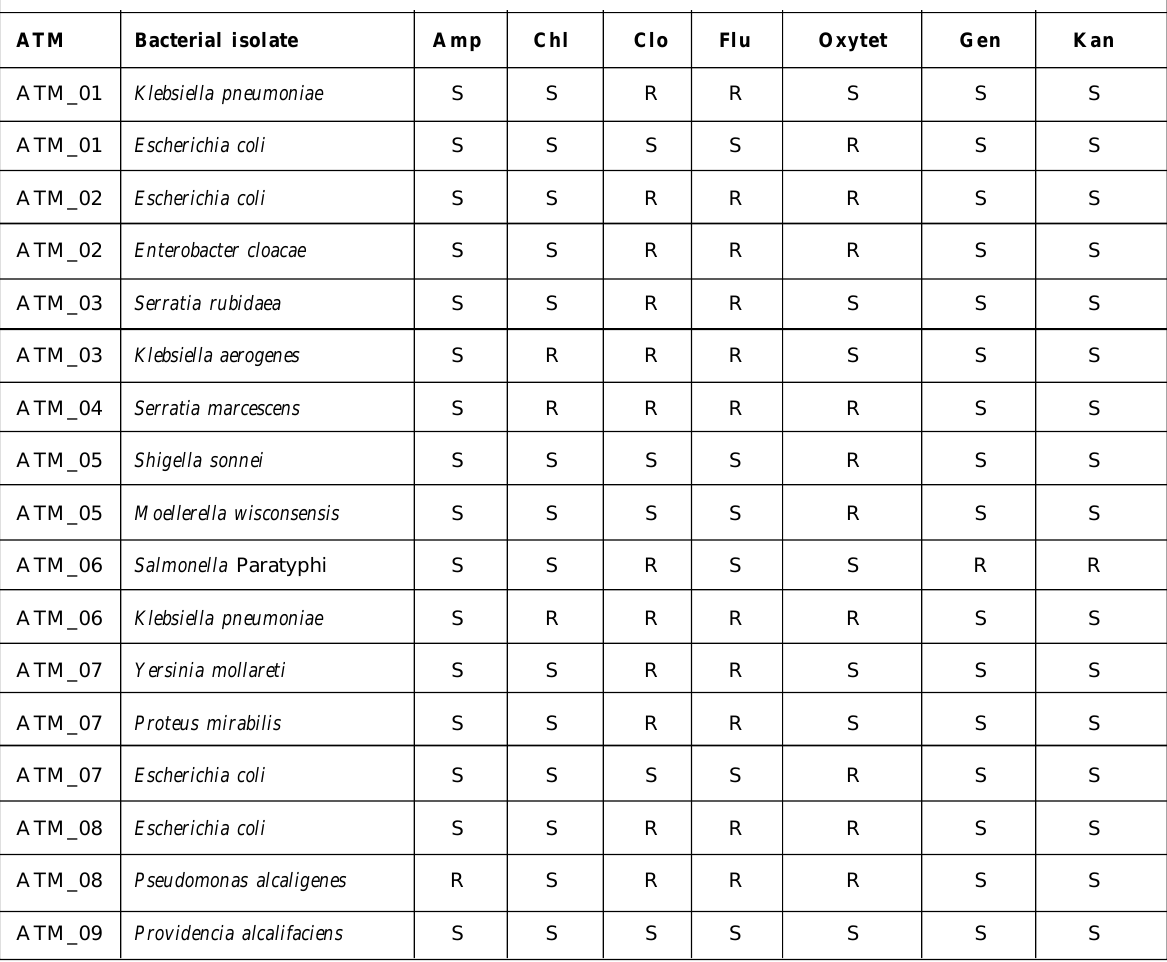
Table 1: Resistance and susceptibility patterns of the bacterial isolates to antibiotics